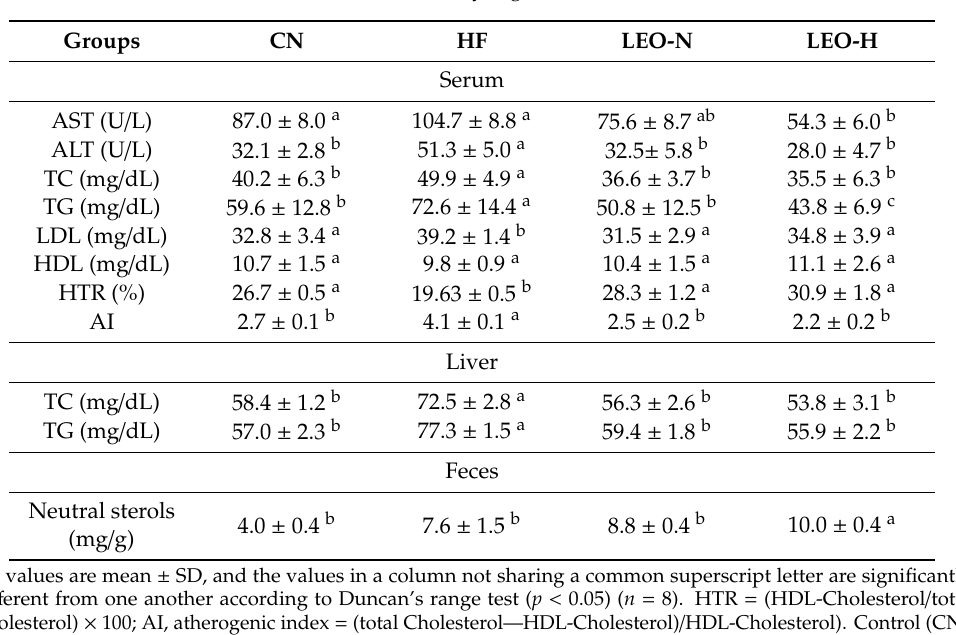
Table 3. Effects of lime essential oils on serum lipids, cholesterol, and triglyceride in the liver and neutral sterols in the feces of Wistar rats induced by high-fat diets. Groups